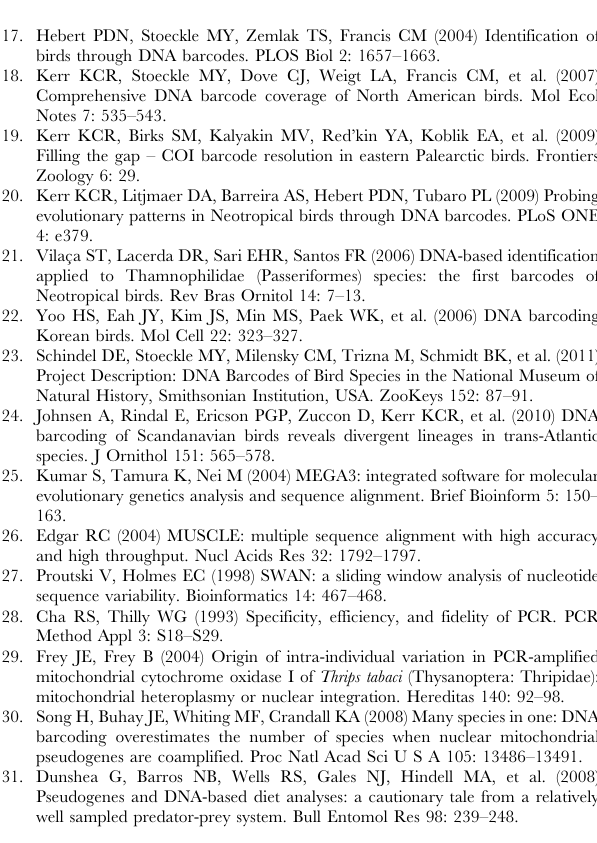
Figure S1 Sliding window analysis (window = 30 nucle- otides) of singleton and shared nucleotide VLFs in avian BARCODEs. (TIF) Fiure S2 BOLD ID Tree for Nothoprocta ornata BAR- CODE JQ175578. The query BARCODE with no VLFs shown